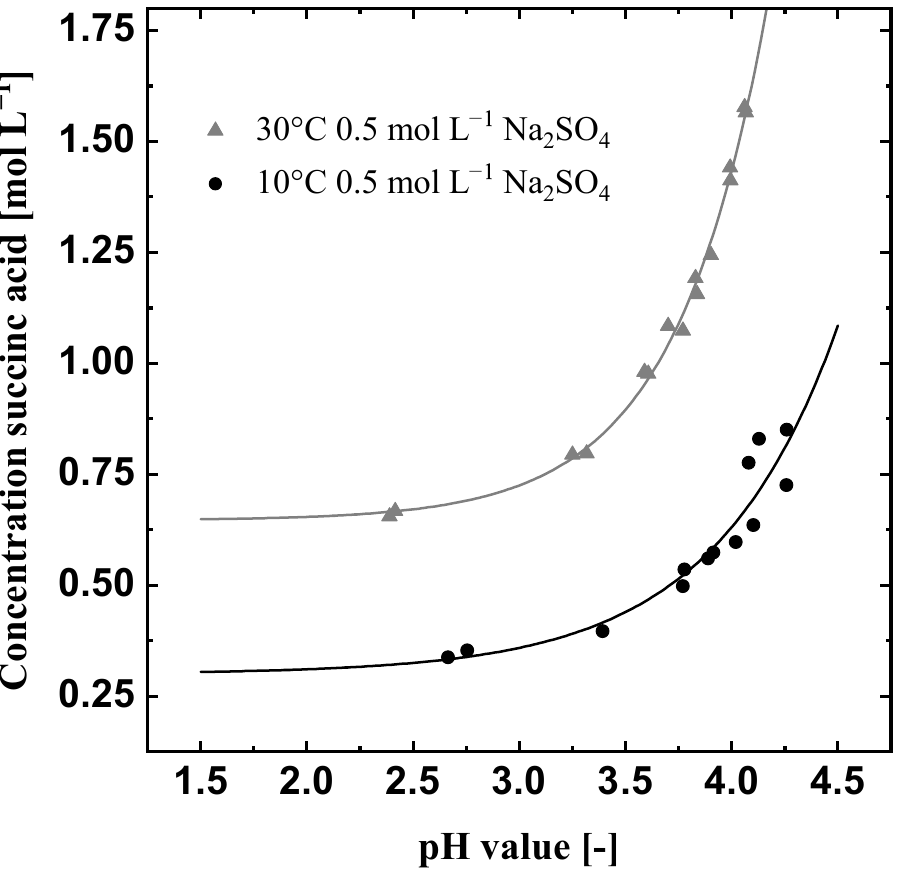
Figure 4. Influence of the pH value on the solubility concentration of succinic acid in aqueous Na 2 SO 4 solutions at 10°C and